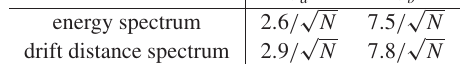
σ σ √ √ a b N 7 . 5 / N √ √ N 7 . 8 / N